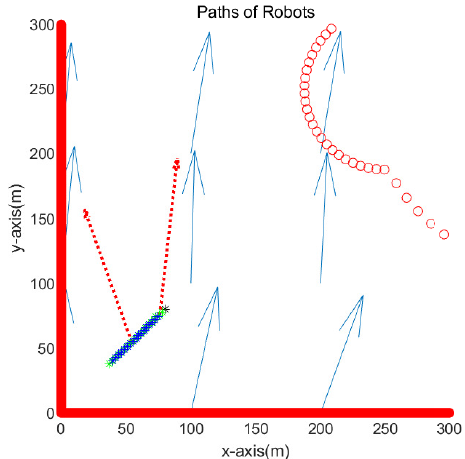
Figure 4. Scenario 1. The path of one robot is depicted with blue asterisks, and that of another robot is depicted with green asterisks. Red dotted arrows show the perturbation vector field estimated at the robot’s